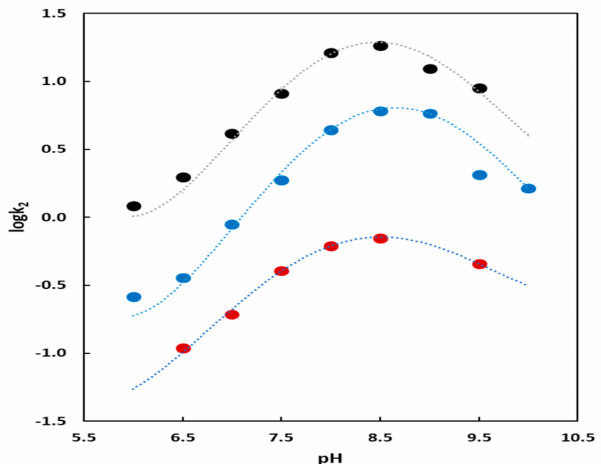
Figure 5. Dependence of the second order rate constant (k 2 ) from pH for the catalysts AuNP-1, AuNP2 and AuNP4. The dotted lines represent the best fitting of the experimental data by using Equation (1). Black circles: AuNP2; blue circles: AuNP1 and red circles AuNP4. Conditions: [AuNP1 in thiol units] = [Zn(II)] = 1.7 × 10 − 5 M, [HPNP] = 1.0 × 10 − 3 M, 25 ◦ C in H = [Zn(II)] = 2 O; [AuNP2]. (in thiol units) 3.47 × 10 − 5 M, [HPNP] = 7.0 × 10 − 4 M, 40 ◦ C in H 2 O; [AuNP4] (in thiol units) = [Zn(II)] = 1.43 × 10 − 5 M, [HPNP] = 5.0 × 10 -4 M, 40 ◦ C in H 2 O; [bu ff ers] = 1.0 × 10 − 2 M in all